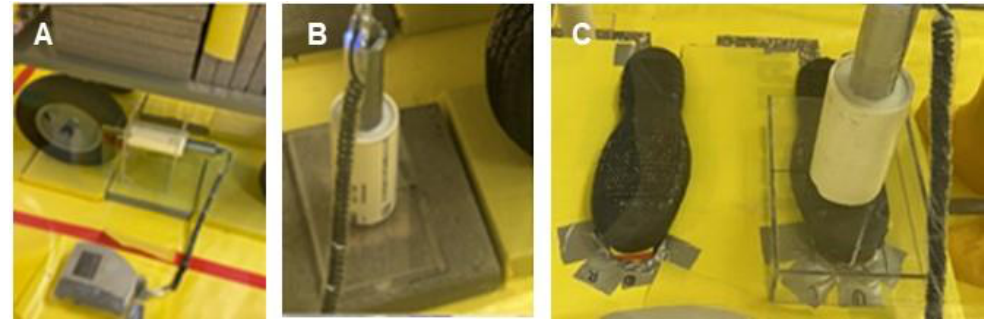
Figure 2. Activity Measurement Using Frames Customized to ( A ) Tires; ( B ) Surfaces; and ( C ) Boots.